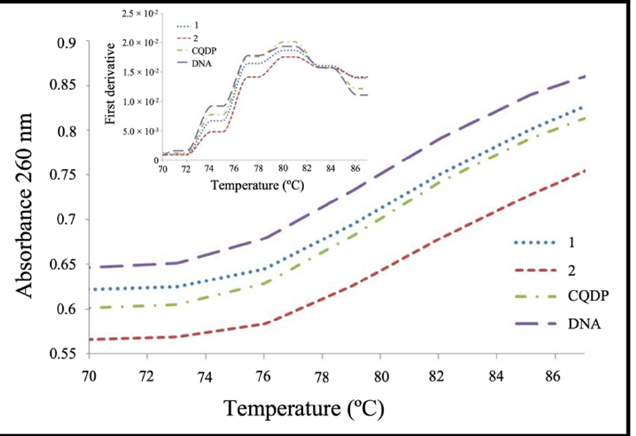
Figure 6. Thermal denaturation of CT-DNA alone (purple long dash line) and with the [Cu(CQ)(PPh 3 ) 2 ]NO 3 , complex 1 (blue dot line), [Cu(CQ)2]Cl, complex 2 (red dash line) and CQDP (green dash dot line) at a molar ratio, Ri = 0.05.